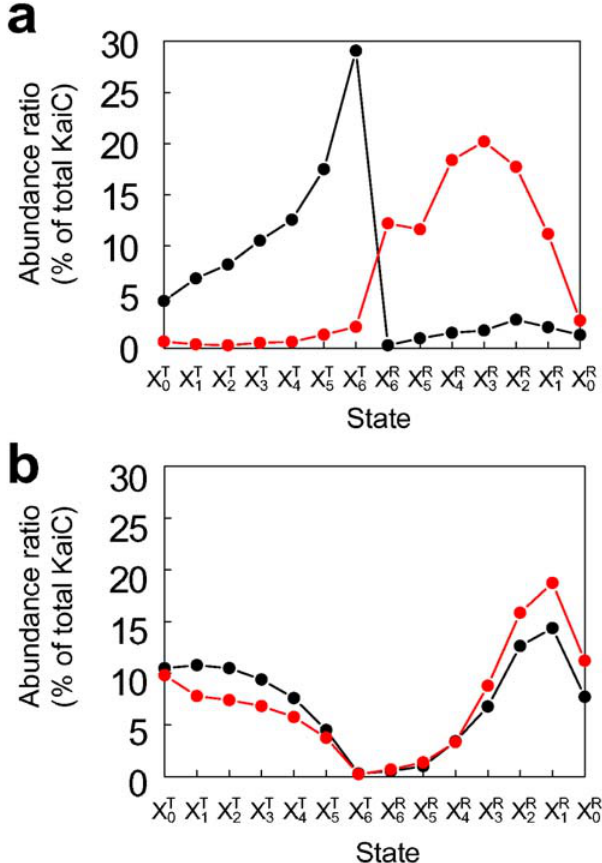
Figure 3. Typical examples of distributions of KaiC states,P(R i ,t)=X iR / X and P(T i ,t)=X iT /X. (a) Distributions at t =18 hours (black line) and t =22 hours (red line) calculated with the standard parameter set consistent with the autocatalytic increase of KaiC population in R states. (b) Distributions at t =10 hours (black line) and t =14 hours (red line) calculated with the transition rate from T 6 to R 6 increased 100-fold from its standard value.